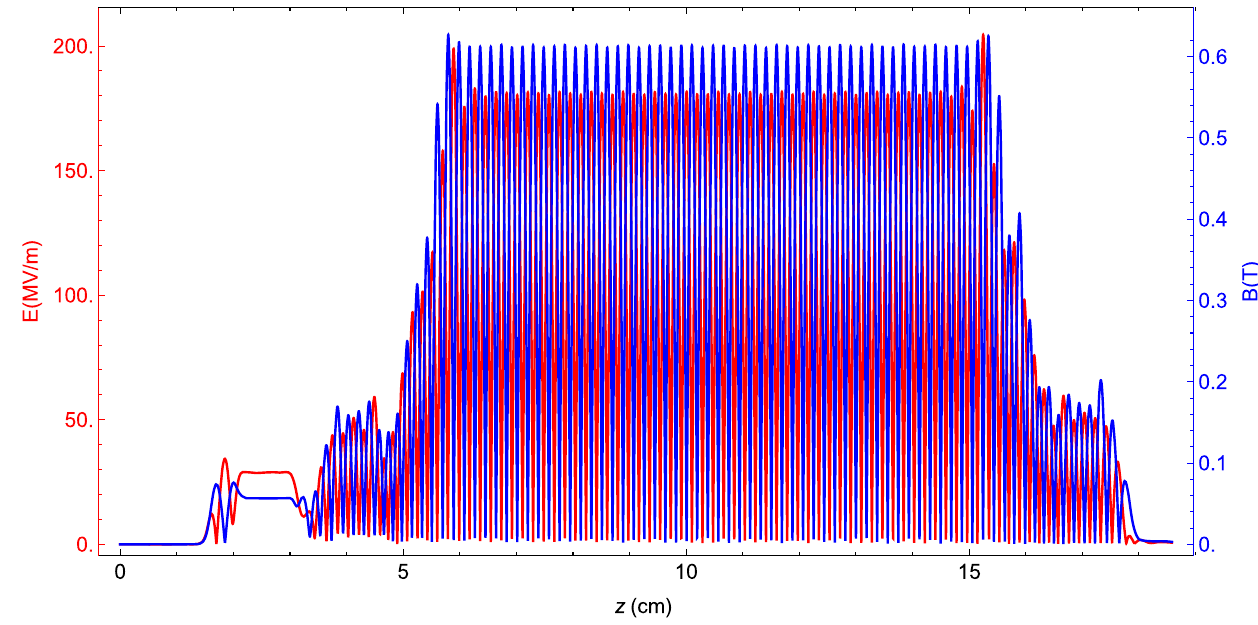
FIG. 29. Radio frequency undulator cavity on-axis field profile with the dual-moded bend, adapted from Toufexis et al.